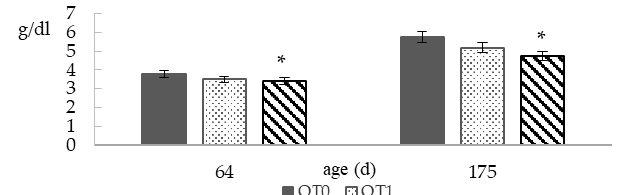
Figure 3. Total blood protein (TBP) from birds fed different levels of QT (mean ± SEM) for a 140-day period starting from 35 days old. * Indicates a difference between treatment and QT0 (Dunnett’s t - test, p < 0.05). QT0 = basal diet; QT1 and QT2 = the basal diet supplemented with QT at 1% and 2%, respectively.